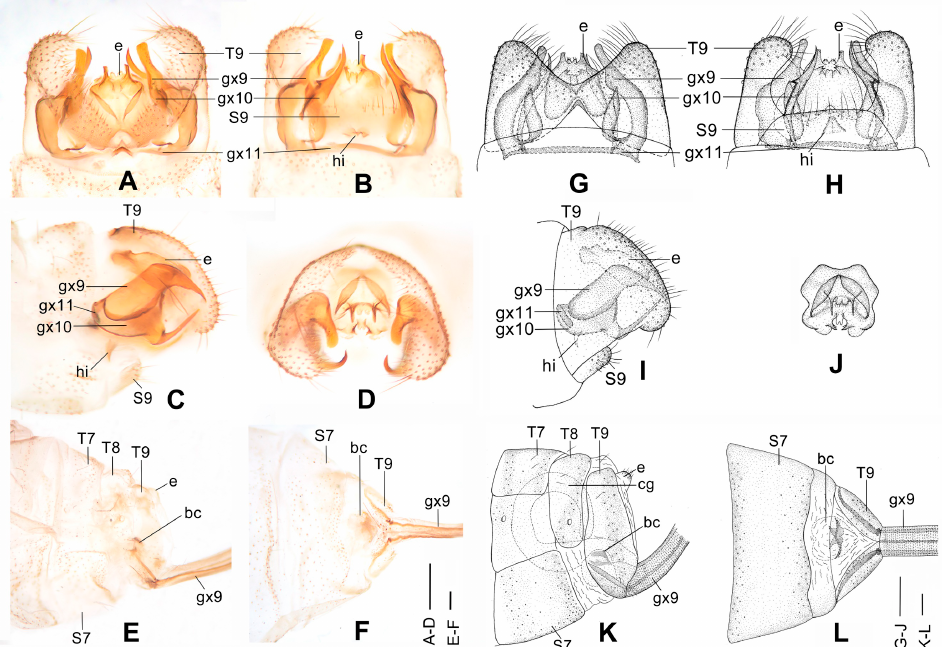
Figure 5. Dilar daweishanensis sp. nov. ( A – D ) male holotype, genitalia, photographs: ( A ) dorsal view; ( B ) ventral view; ( C ) lateral view; ( D ) caudal view. ( E – F ) female, genitalia, photographs: ( E ) lateral view; ( F ) ventral view. ( G – J ) male holotype, genitalia, line drawings: ( G ) dorsal view; ( H ) ventral view; ( I ) lateral view; ( J ) ectoproct, caudal view. ( K – L ) female, genitalia, line drawings: ( K ) lateral view; ( L ) ventral view. bc: bursa copulatrix; cg: colleterial gland; e: ectoproct; gx9: gonocoxite 9; gx10: gonocoxite 10; gx11: fused gonocoxites 11; hi: hypandrium internum; S7–9: sternum 7–9;